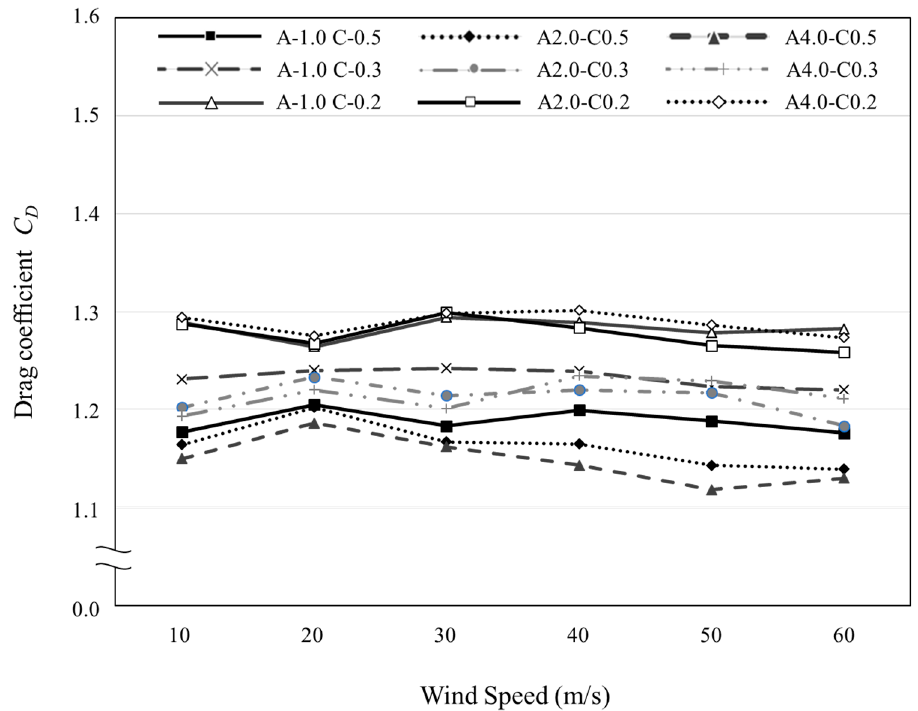
Figure 12. Correlation between wind speed and drag coefficient.